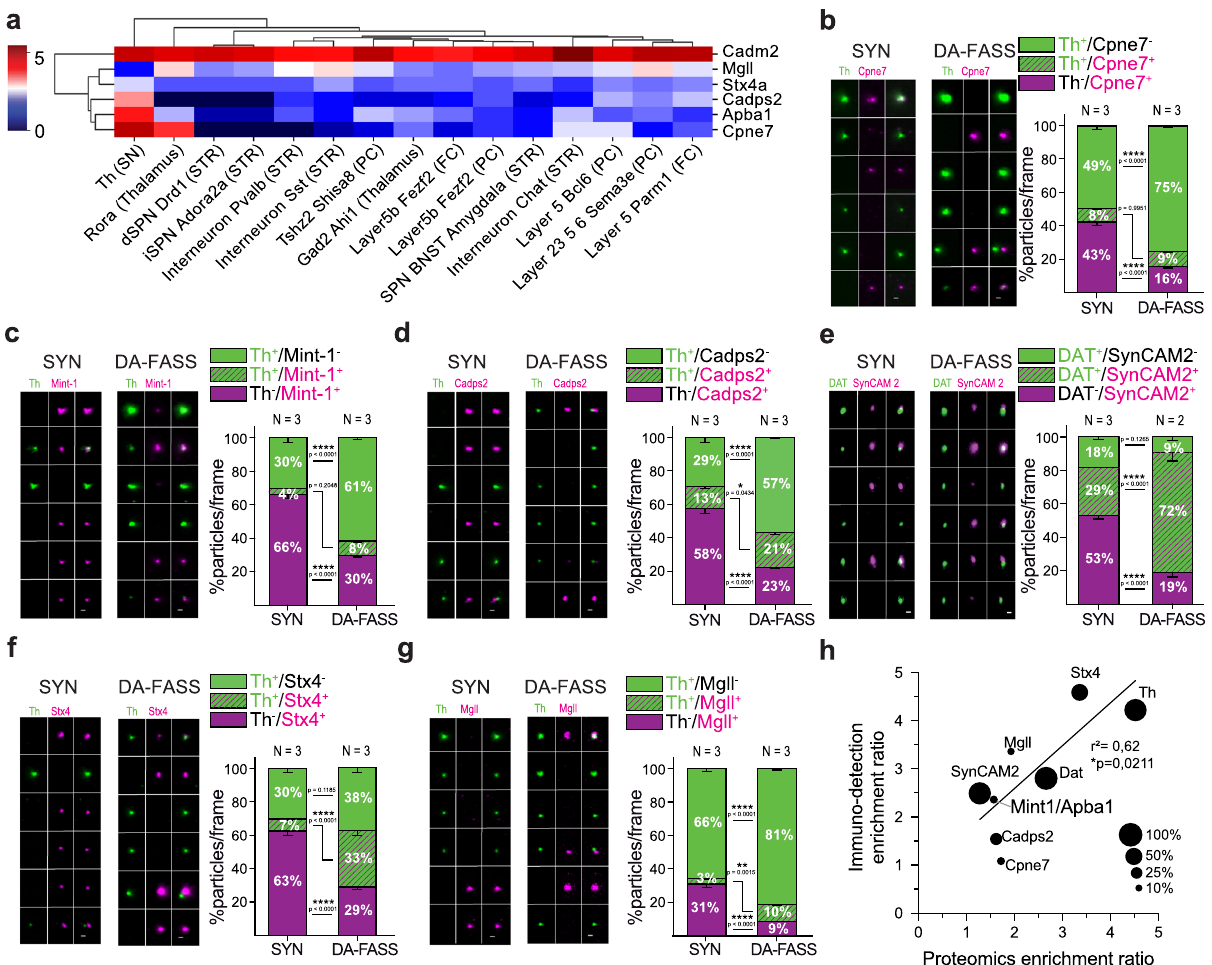
Fig. 4 Validation of a selected set of DA-FASS enriched proteins with immuno fl uorescence. a Heatmap showing cell type speci fi c mRNA abundance of the 6 DA-FASS proteins selected for further experimental validation (detailed from Fig. 3h). b – g Epi fl uorescence images of a representative sample of synaptosome populations labelled with b – d, f, g anti-Th (green) or e DAT and b anti-Cpne7, c Mint-1/Apba1, d Cadps2, e SynCAM 2/Cadm2, f Stx4, g Mgll (magenta) and analysis of staining showing particle proportions per frame. All data are mean ± SEM and pulled from N = 2 to N = 3 independent sorts and n = 5 to n = 11 fi eld of view per independent sort. Each independent sort pooled at least 3 animals. Statistical signi fi cance was analyzed using Two-way ANOVA, b Th/Cpne7: Interaction F 2,180 = 131.9 **** p < 0.0001, Condition F 1,180 = 0.0004 p = 0.984, Immunolabelling F 2,180 = 570.4 **** p < 0.0001; c Th/Mint-1: Interaction F 2,183 = 163.7 **** p < 0.0001, Condition F 1,183 = 0.0009 p = 0.975, Immunolabelling F 2,183 = 316.5 **** p < 0.0001; d Th/Cadps2: Interaction F 2,187 = 110.5 **** p < 0.0001, Condition F 1,187 = 0.004 p = 0.951, Immunolabelling F 2,187 = 88.12 **** p < 0.0001; e DAT/ SynCAM 2: Interaction F 2,60 = 84.92 **** p < 0.0001, Condition F 1,60 = 4.371e-005 p = 0.995, Immunolabelling F 2,60 = 73.75 **** p < 0.0001 f Th/Stx4: Interaction F 2,177 = 69.25 **** p < 0.0001, Condition F 1,177 = 0.004 p = 0.95, Immunolabelling F 2,177 = 49.15 **** p < 0.0001; g Th/Mgll: Interaction F 2,192 = 98.57 **** p < 0.0001, Condition F 1,192 = 4.217e-005 p = 0.995, Immunolabelling F 2,192 = 1242 **** p < 0.0001 with Š ídák ’ s multiple comparisons test. For all panels, scale bar = 1 μ m. h Correlation between protein immunodetection and label-free mass spectrometry-based enrichment ratios (Two- tailed Pearson ’ s correlation coef fi cient * p = 0.021, r 2 = 0.62). Correlated data are pulled from independent experiments. Dot sizes are scaled to the proportion of dopaminergic synaptosomes expressing each (SYN: EGFP − /Synapsin + = 83.2 ± 1.1%; DA-FASS: EGFP − /Synap- compared our screen with neurotransmission pathways reported in KEGG (Fig. 3i). The pathway of SV and neurotransmitter cycling sin + = 33.8 ± 2.4%, N = 2 and N = 3 sorts, n = 9 and 10 fi eld of view, respectively; SYN-DA-FASS Š ídák ’ s multiple comparison shares a very high coverage with our proteome (50 protein families **** p < 0.0001). (Fig. 5b). present out of 71 listed in the pathway; Fig. 5a grey boxed text, Supplementary Tables 3 and 5). To complete this observation, we probed for the phospho-proteins Synapsin 1&2 that are found at all presynapses 50 (abundance ratio 1.03 for both isoforms in our screen). EGFP + /Synapsin + synaptosomes representation rises from 7 to 45% upon DA-FASS (SYN: EGFP + /Synapsin + = 6.6 ± 1.2%; DA-FASS: EGFP + /Synapsin + = 44.9 ± 3.3%, N = 2 and N = 3 sorts, n = 9 and 10 fi elds of view respectively; SYN-DA-FASS Š ídák ’ s multiple comparison **** p < 0.0001; Fig. 5b) while EGFP − /Synapsin + synaptosomes are reduced from 83 to 34% after sort (SPNs) 5,51 . VGLUT1 varicosities are opposed to EGFP